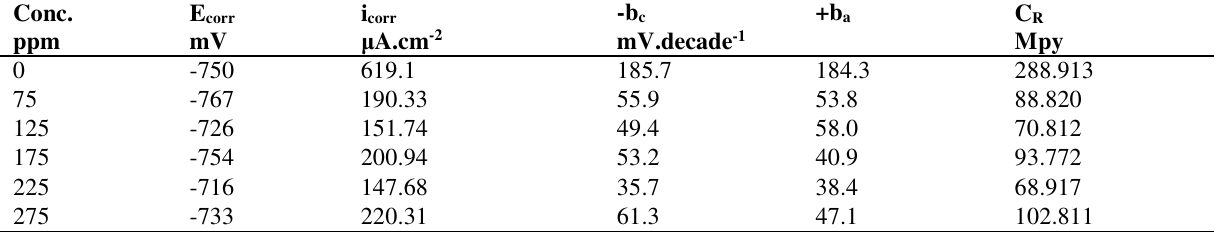
Measured data of polarization behavior for inhibition at 60 o C in 0.5M H 3 PO 4